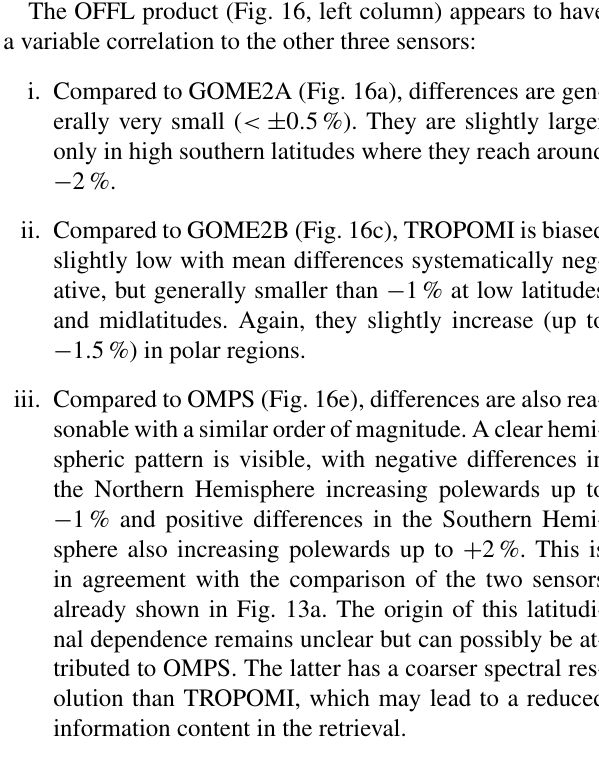
Table 4. The statistical analysis of the differences in percent be- tween the two TROPOMI TOC products and the respective sensors to which they were compared to, as discussed in Sect. 4.1 and